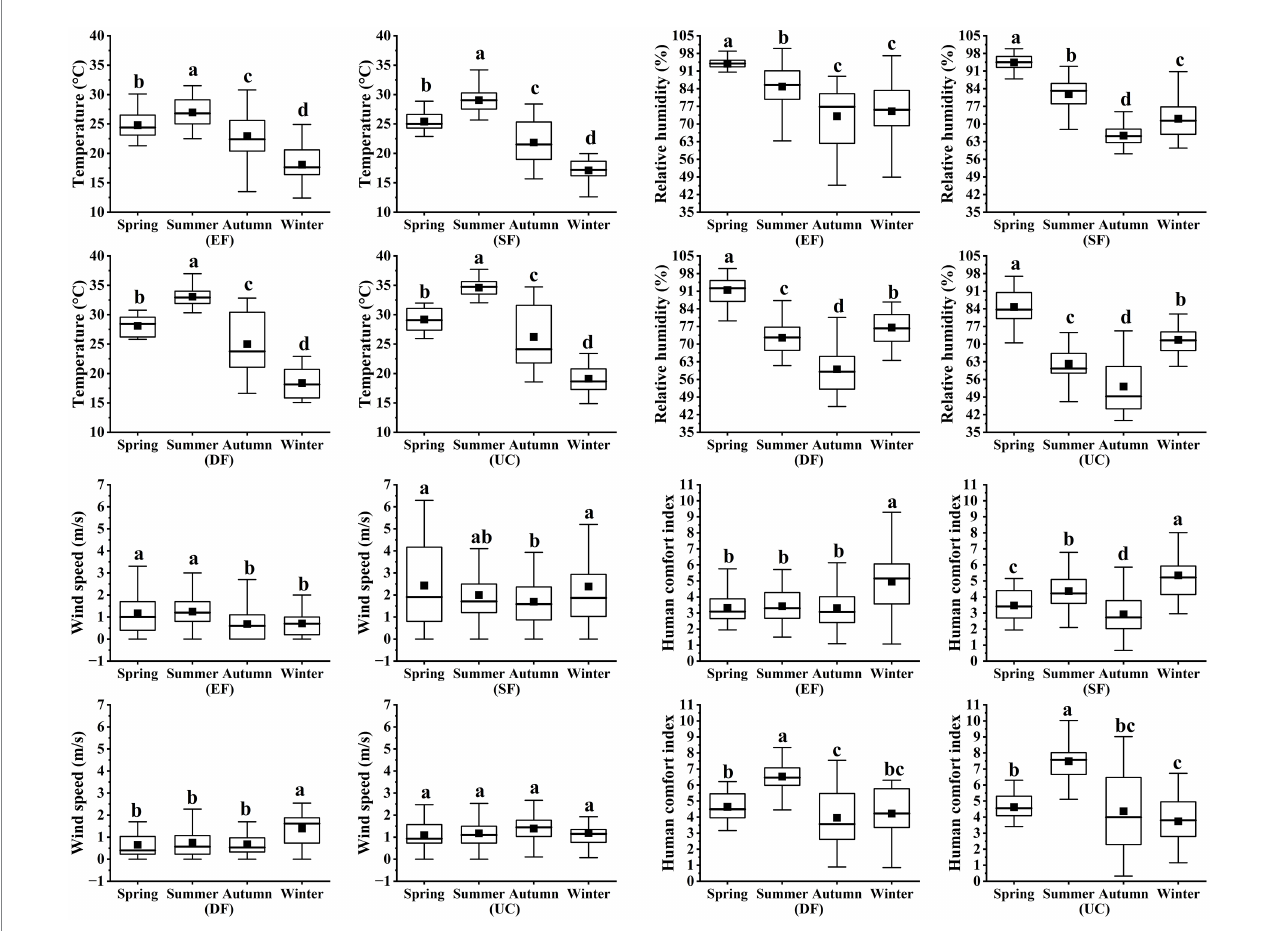
FIGURE 8 Seasonal variations of forest microclimate and HCI of urban forests in different geographical spaces.